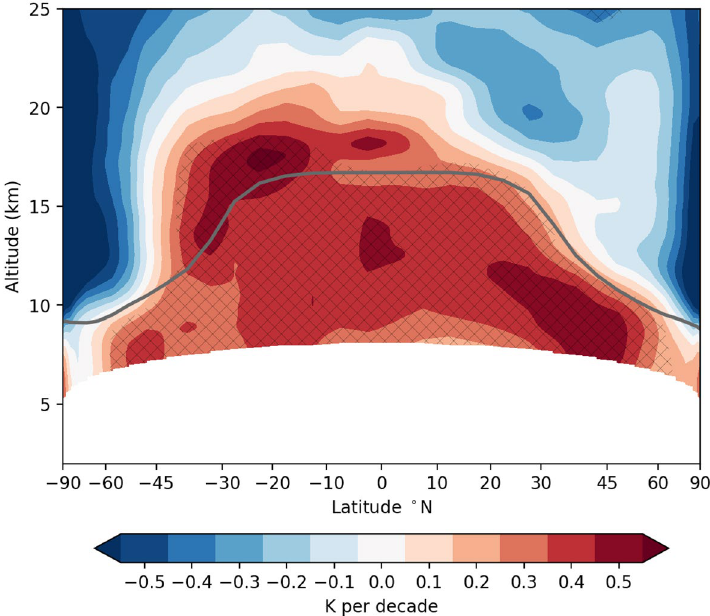
Figure 1. Observed global atmospheric temperature trends in the UTLS from January 2002 to December ◦ 2021, with a latitudinal resolution of 5 . The gray line indicates the height of the tropopause. Areas with trends significant at the 95% level are marked with black